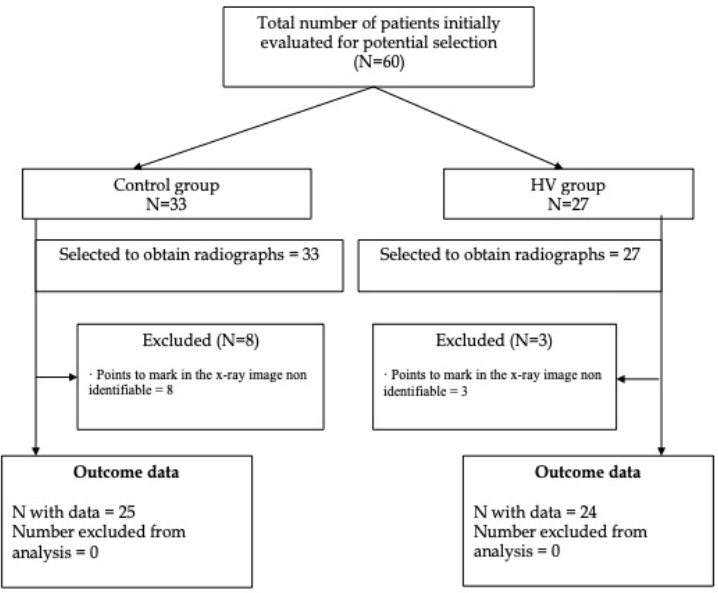
Figure 5. Flow Figure 5. Flow diagram.